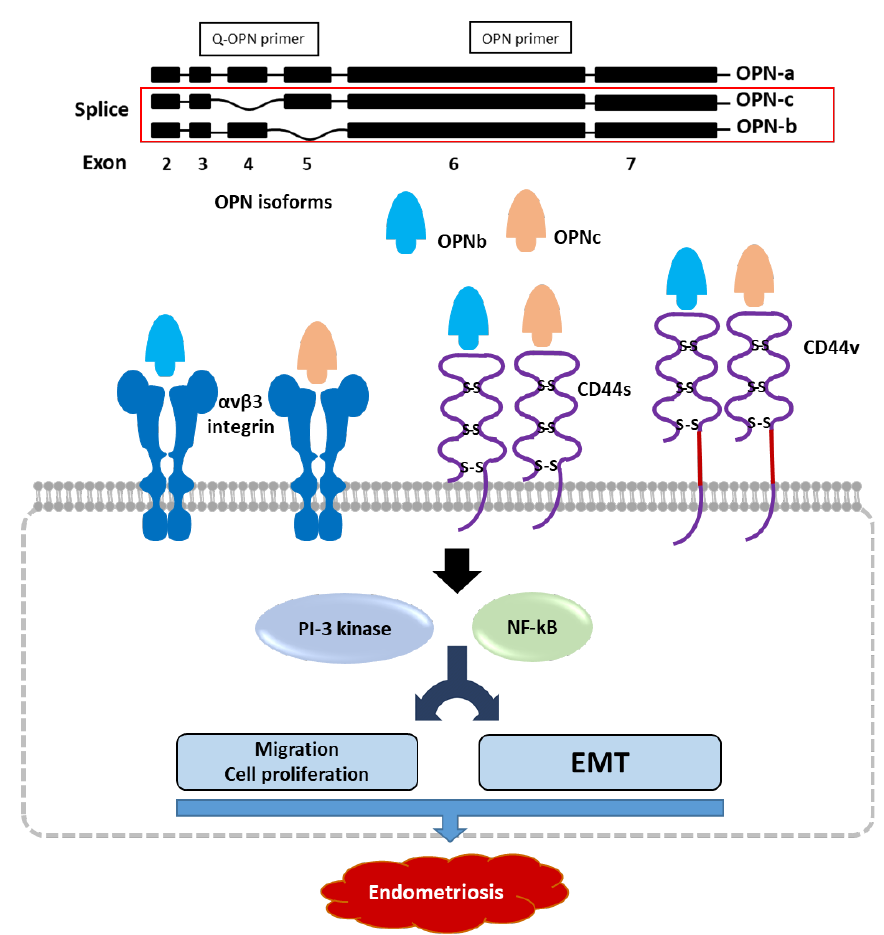
Figure 9. Schematic illustration of the role of OPN isoforms in endometriosis pathogenesis. OPNb and OPNc bind to OPN- ligand receptors CD44 and αvβ3 integrin, activating the PI3K and NFkB pathways, thereby inducing endometriotic cellular migration, proliferation, and the epithelial-mes- enchymal transition process.